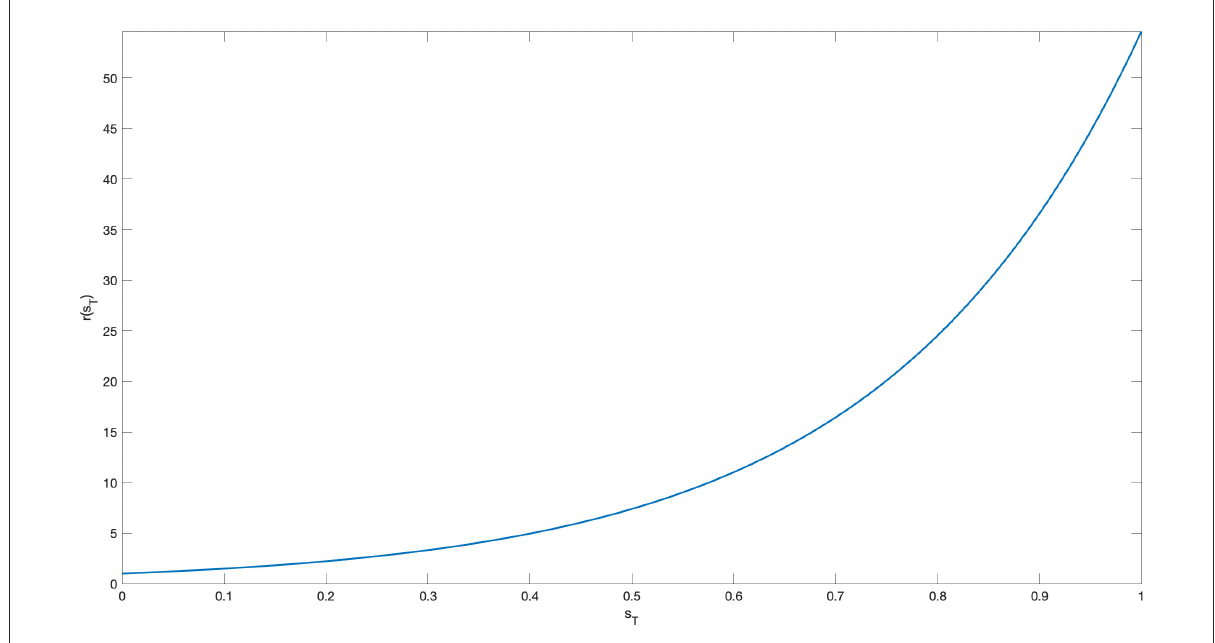
FIGURE4 Terminal reward as a function of the level of awareness at the final time instant.